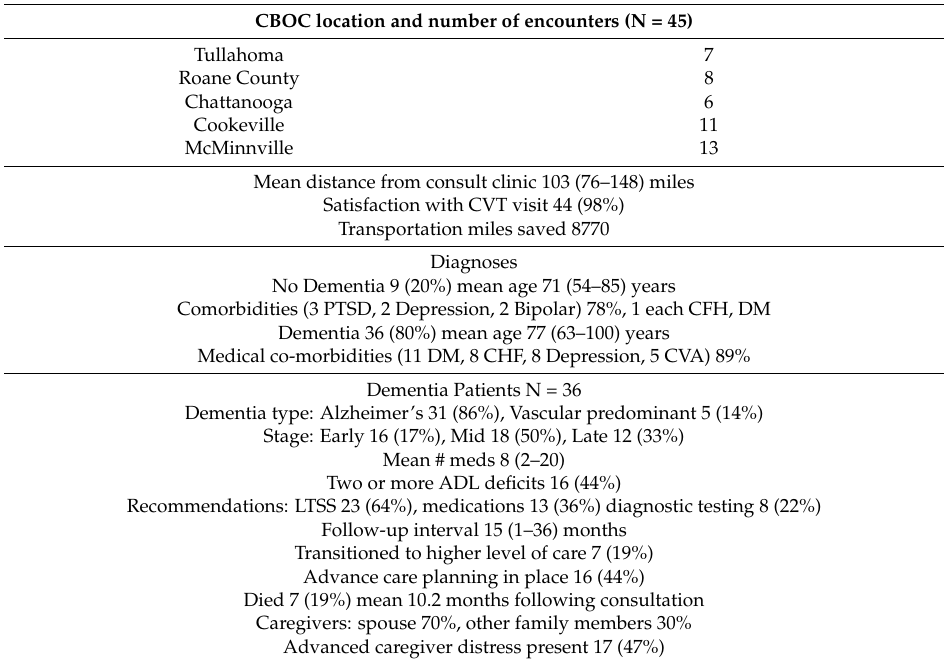
Table 1. CVT Encounters (March 2015–March